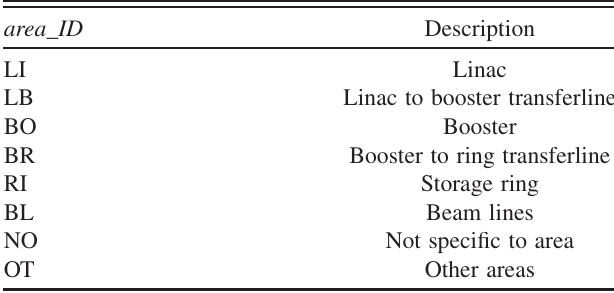
TABLE II. SLS failure areas.